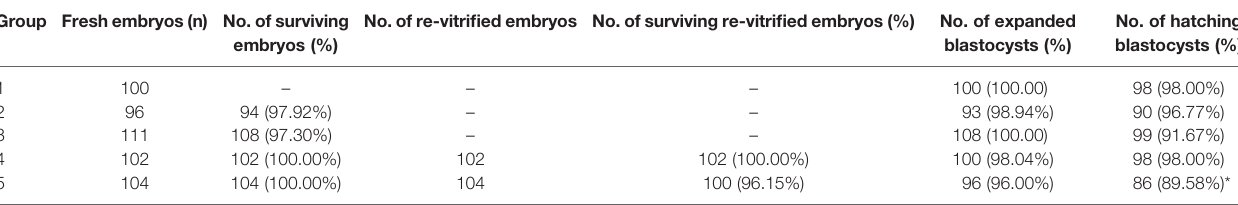
TABLE 3 | Effect of re-vitri fi cation in different stages on mouse embryonic development. Group Fresh embryos (n) No. of surviving embryos (%)